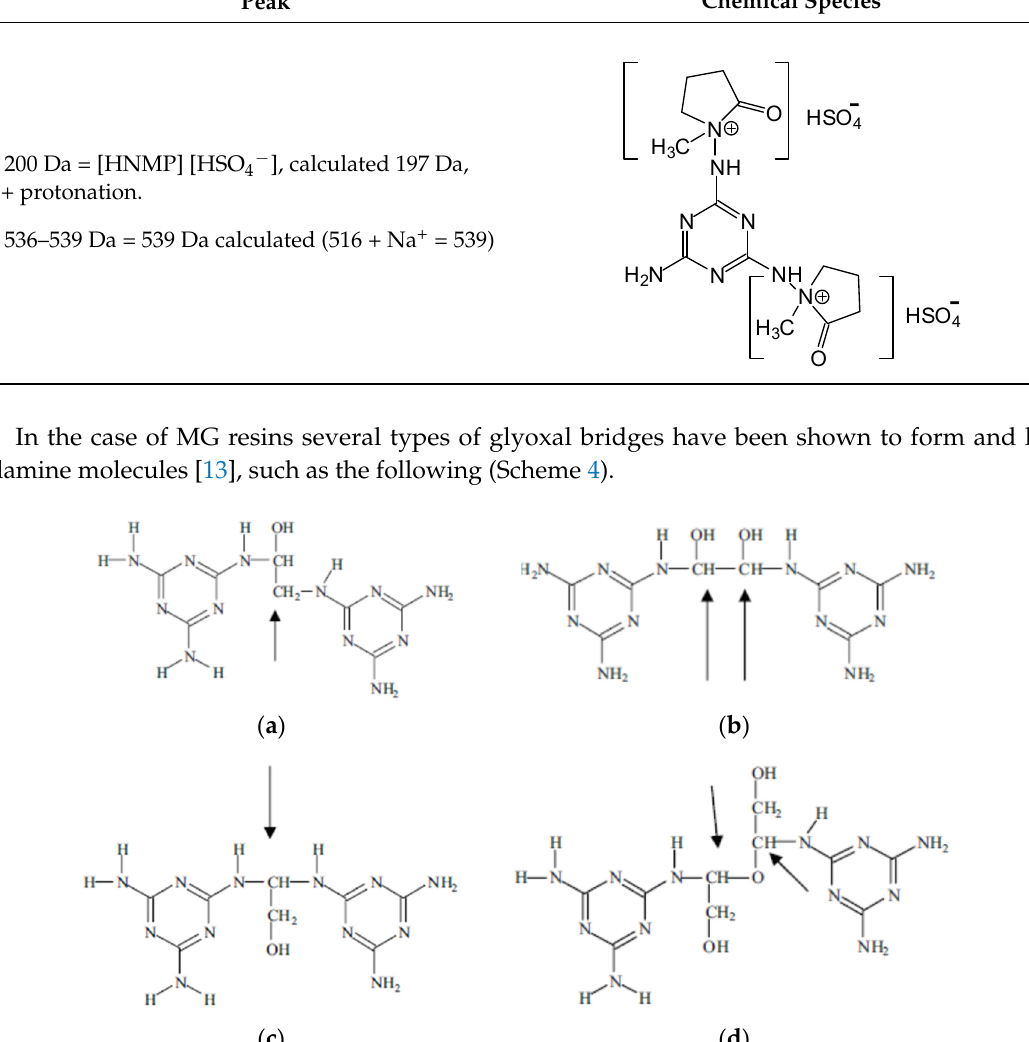
Table 5. Species formed by reaction of IL with melamine alone. Only two peaks could be interpreted. The rest are fragments either coming from impurities or fragments generated in the MALDI. It is clear that the melamine itself is not affected by the IL, although species like the 538 Da could facilitate reaction with the aldehydes. Peak